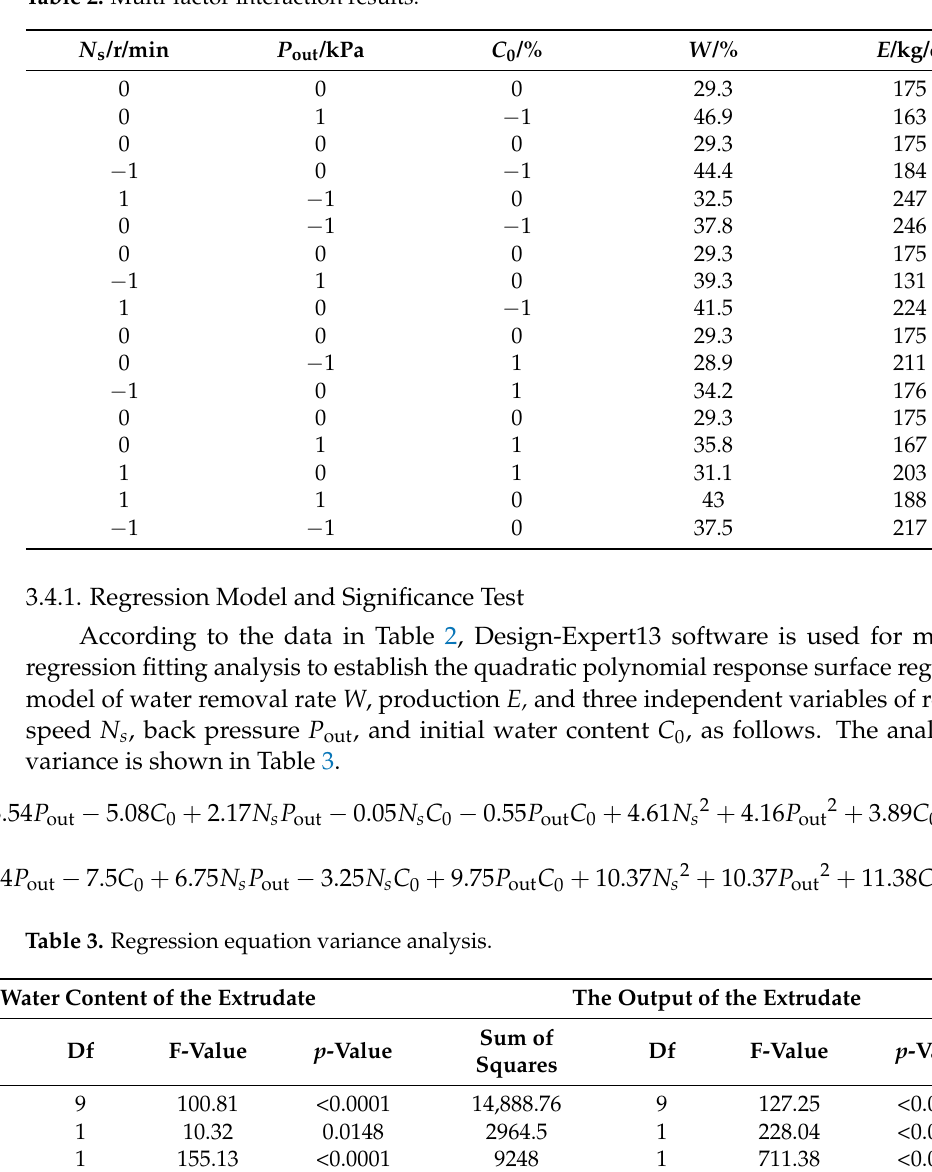
Table 2. Multi-factor interaction results.